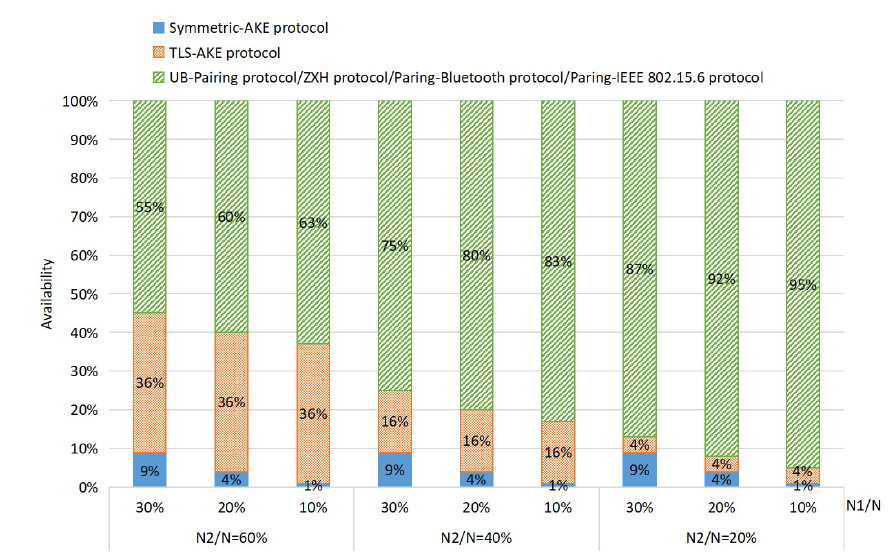
Figure 9. Availability results (b).